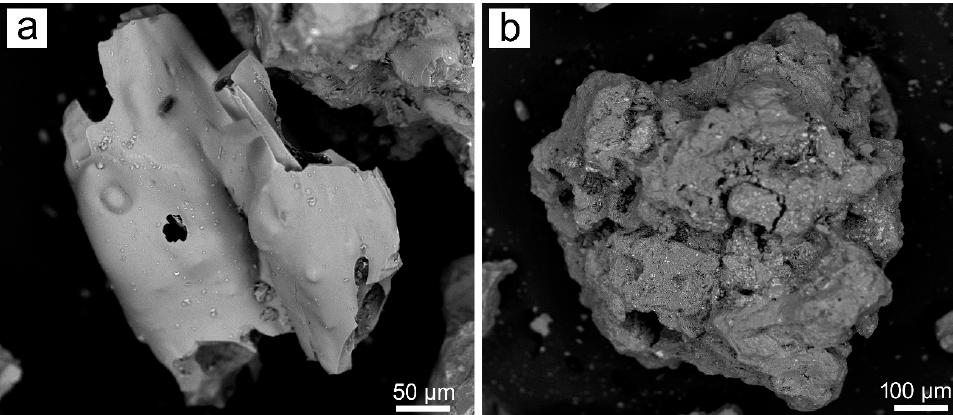
Figure 2. SEM images of sideromelane ( a ) and tachylite ( b ) glass fragments.